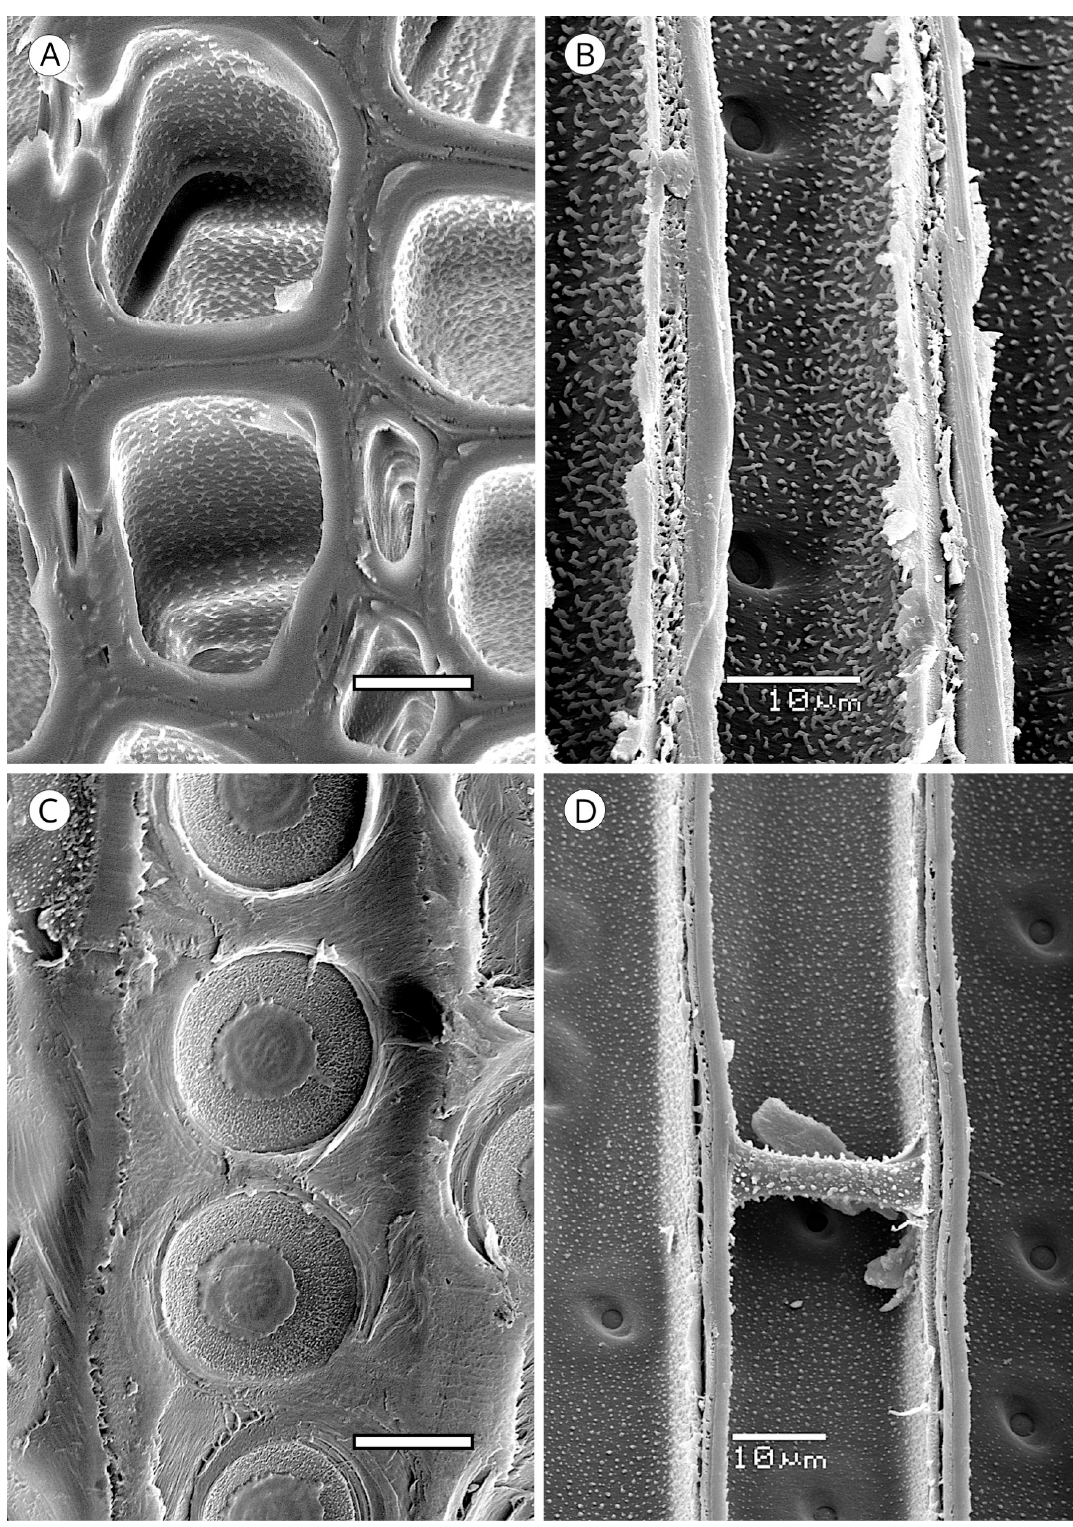
Figure 18. Warty layer (SEM). ( A ) Callitris drummondii (Parl.) Benth. and Hook.f. ex F.Muell.; ( B ) Callitris acuminata (Parl.) F.Muell.; ( C ) Callitris oblonga Rich.; ( D ) Diselma archeri Hook.f. Scale bars. ( A , C ) = 25 μ m.